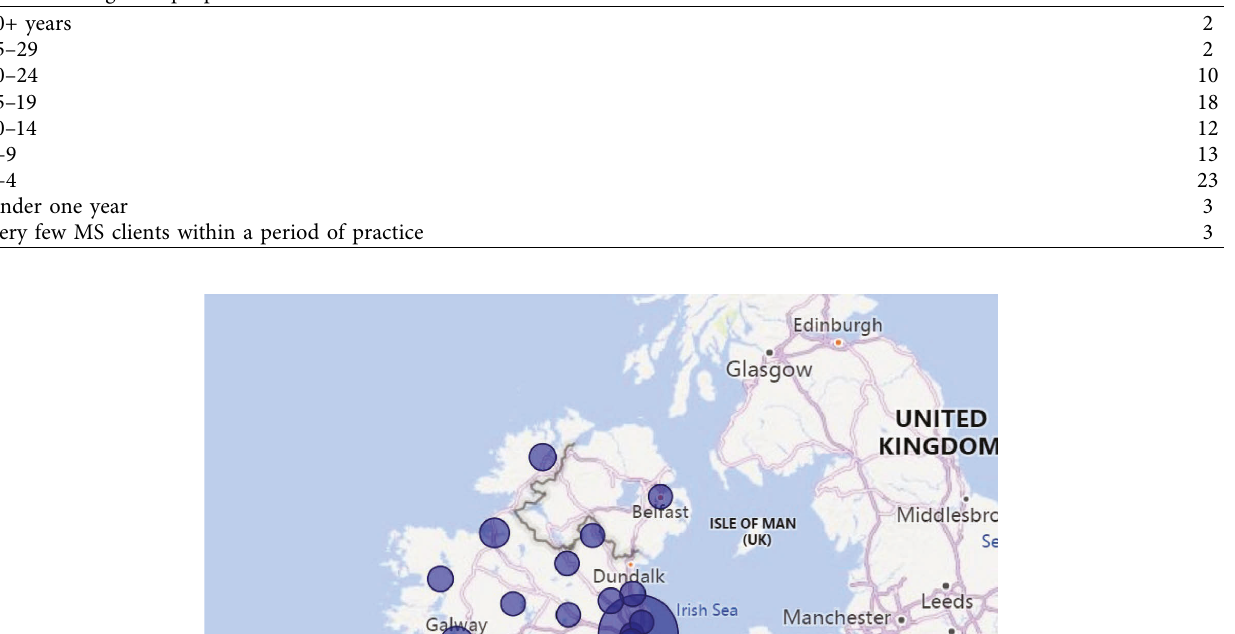
Table 1: The number of years healthcare professionals reported they had been working with people with MS. Years working with people with MS